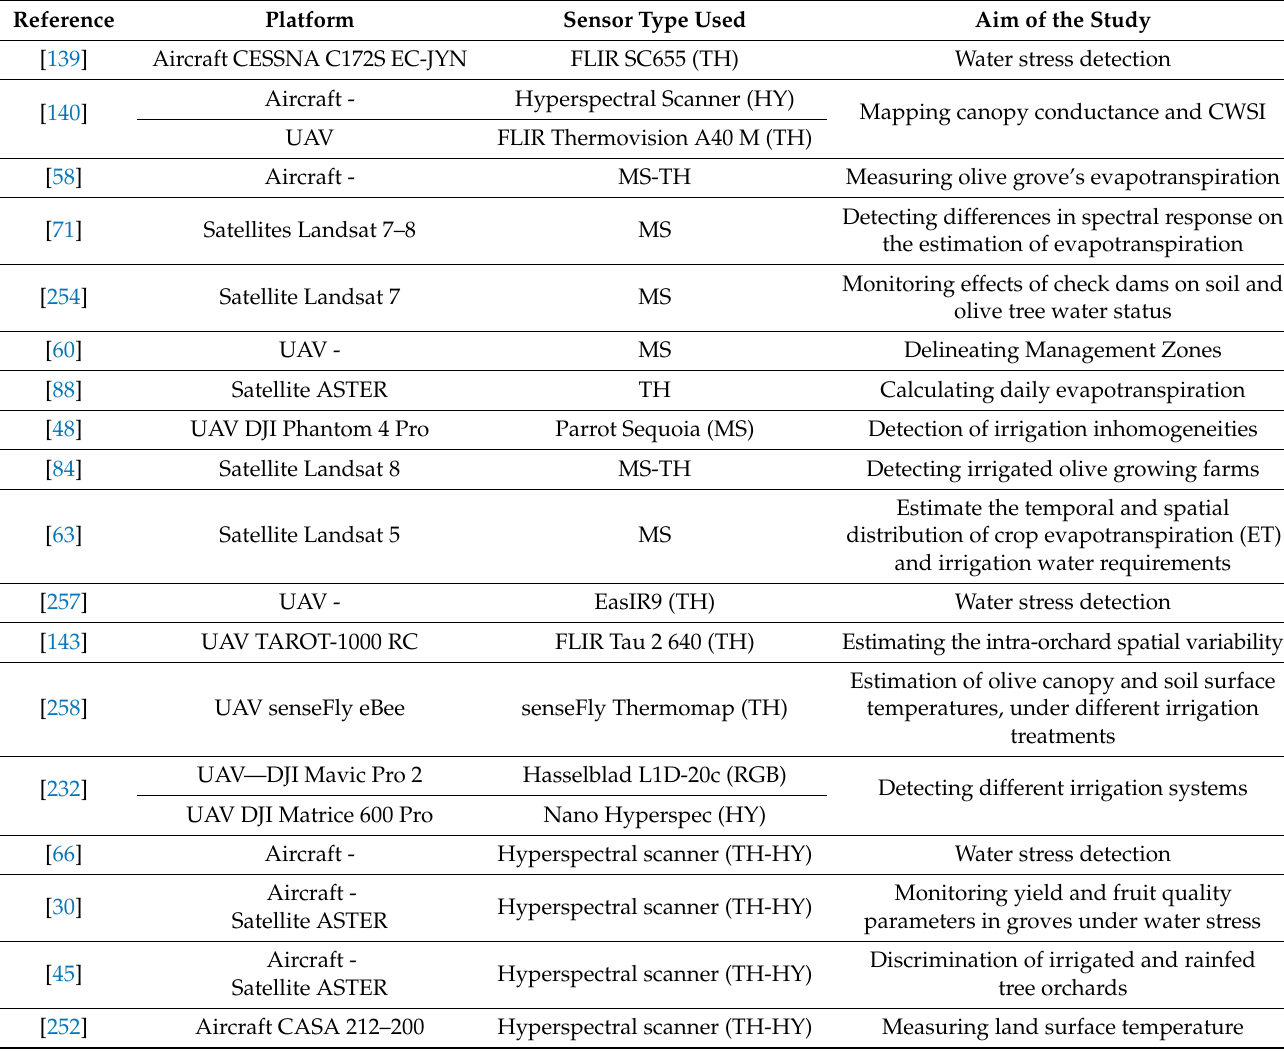
Table 6. References dealing with irrigation water